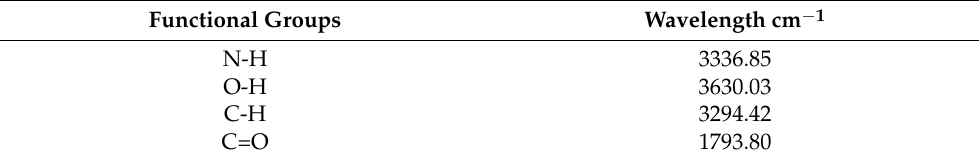
Table 6. Wave number for functional groups of pure PLA.